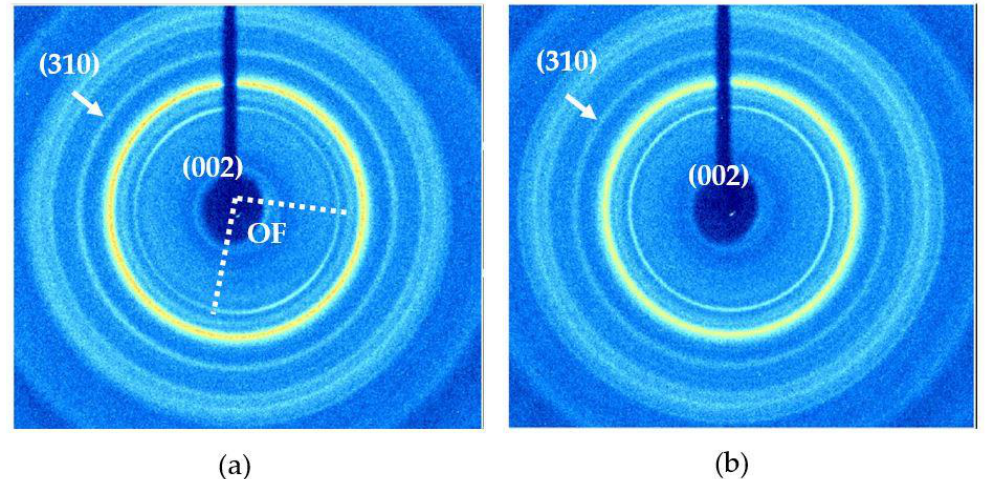
Figure 2. Two-dimensional X-ray diffraction (2D-XRD) patterns from fibula (longitudinal section) ( a ) and cranium ( b ) samples, displaying the peaks and Debye–Scherrer rings for (002) and (310) reflections of hydroxyapatite crystals in bone mineral. OF stands for oriented fraction for angular scattering in the c -axis orientation of HAp crystals. Table 2. Crystals orientation parameters determined by X-ray diffraction in different bone samples obtained by 2D-XRD patterns analyses.